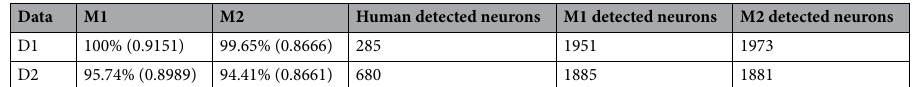
Table 1. Percentage of matched cells and average DICE coefficient of two ANMAF models. M1 and M2 columns present the percentage of manually annotated somatic regions in the datasets D1 and D2 that ANMAF detected, respectively. Parentheses represent the average DICE coefficients between manual and model-generated contours of matched somatic areas. The last three columns demonstrate the total number of neurons labeled by human annotator, M1, and M2,